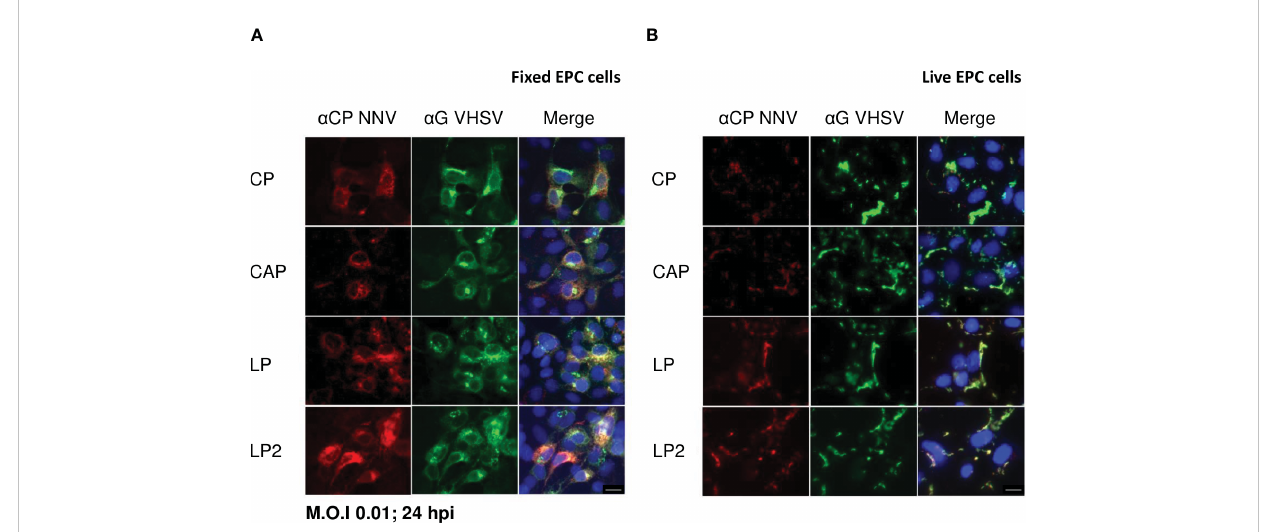
FIGURE 2 Expression of NNV antigens in rVHSVs infected cells. The expression of NNV antigens was assessed by indirect immuno fl uorescence assays on EPC cells. The cells were infected with rVHSV-CP, rVHSV-CAP, rVHSV-LP or rVHSV-LP2 at an MOI of 0.01 and incubated at 14 ˚ C. (A) At 24 h post- infection, cells were fi xed and permeabilized with alcohol/acetone and NNV and VHSV G expression were detected using a pAb against NNV (red) and a mAb against VHSV G (green), respectively. (B) At 24 h post-infection, membrane expression of NNV antigens was visualized on live cells in PBS using the same antibodies. Nuclei were stained with Hoechst (blue). Bars, 10 µm.